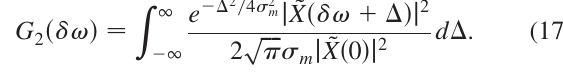
FIG. 1. Comparison between G 2 functions derived for the flattop model and the Gaussian average x-ray profiles. (a) When T Gaussian and flattop profiles having the same rms duration yield different G 2 functions. (b) When T profiles having the same rms duration cannot be